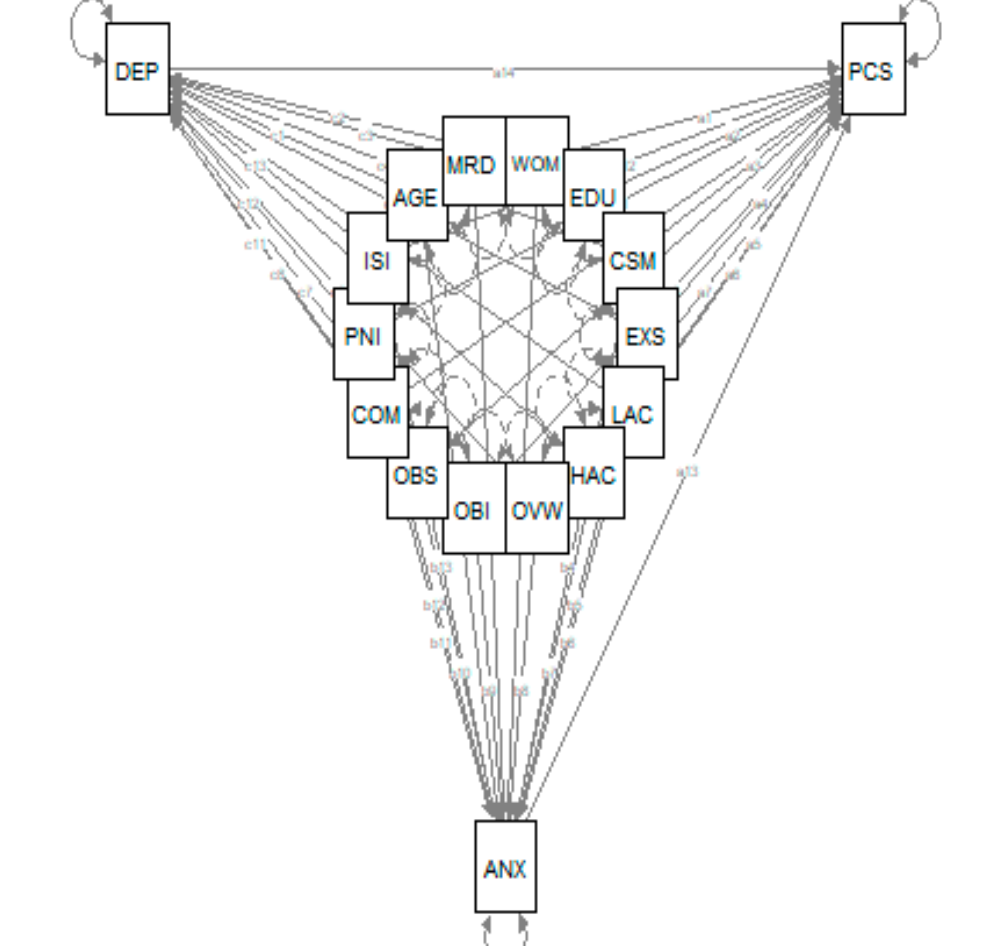
Figure 1. Theoretical model.